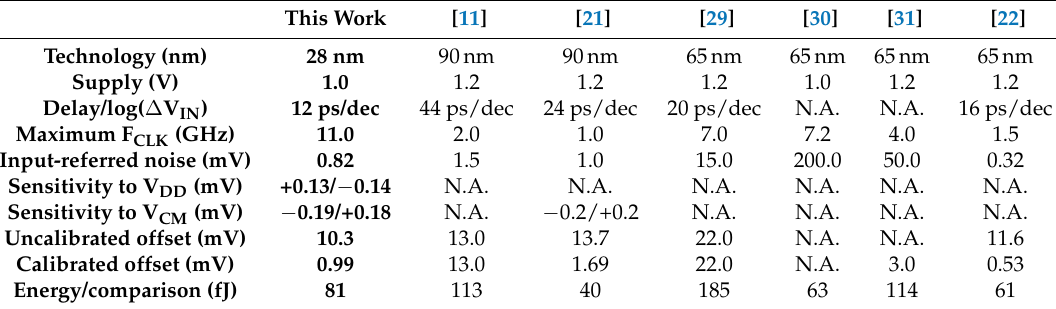
Table 1. Performance summary and comparison with state-of-the-art